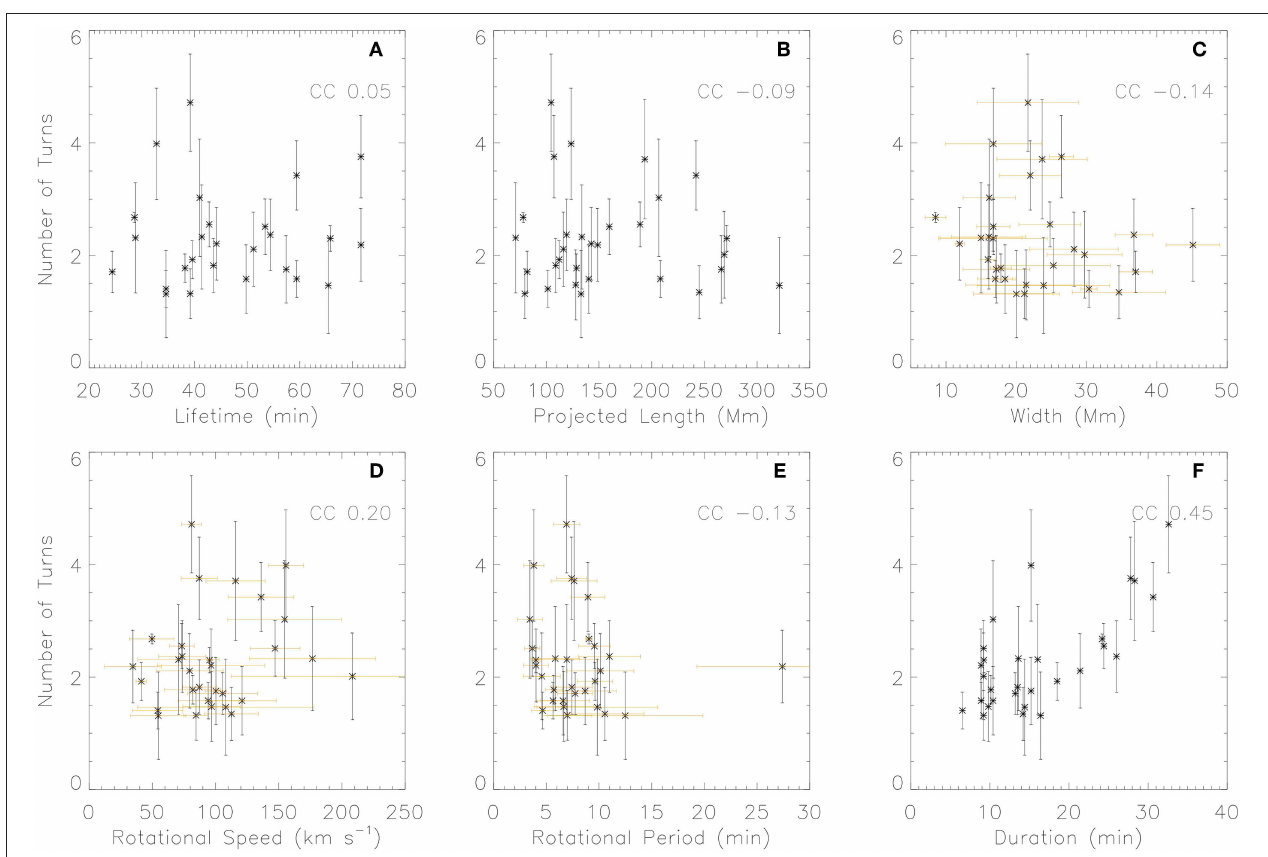
FIGURE 6 | Correlation between various jet parameters (A) lifetime, (B) maximum projected length, (C) width, (D) rotational speed, (E) rotational period, and (F) duration of the rotational motion and the total number of turns these jets rotate. The black vertical lines are indicating the associated errors of the total number of turns. The orange horizontal lines show the errors of the corresponding parameters.